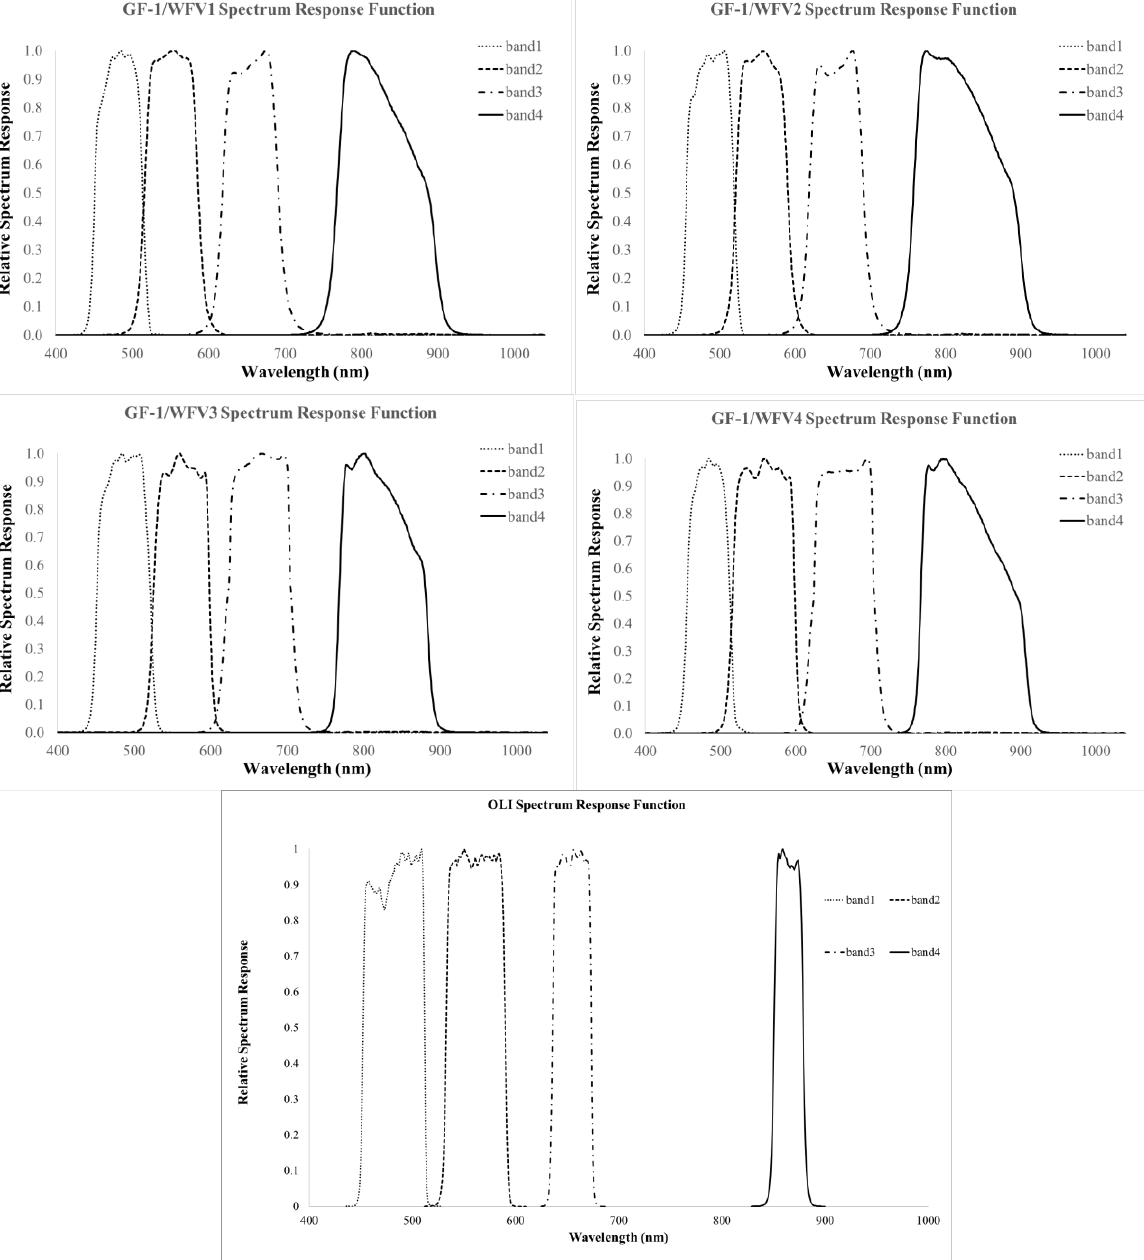
Figure 3. Relative spectral response profiles of GF-1/WFVs and Landsat-8/OLI in corresponding first to fourth wavelength